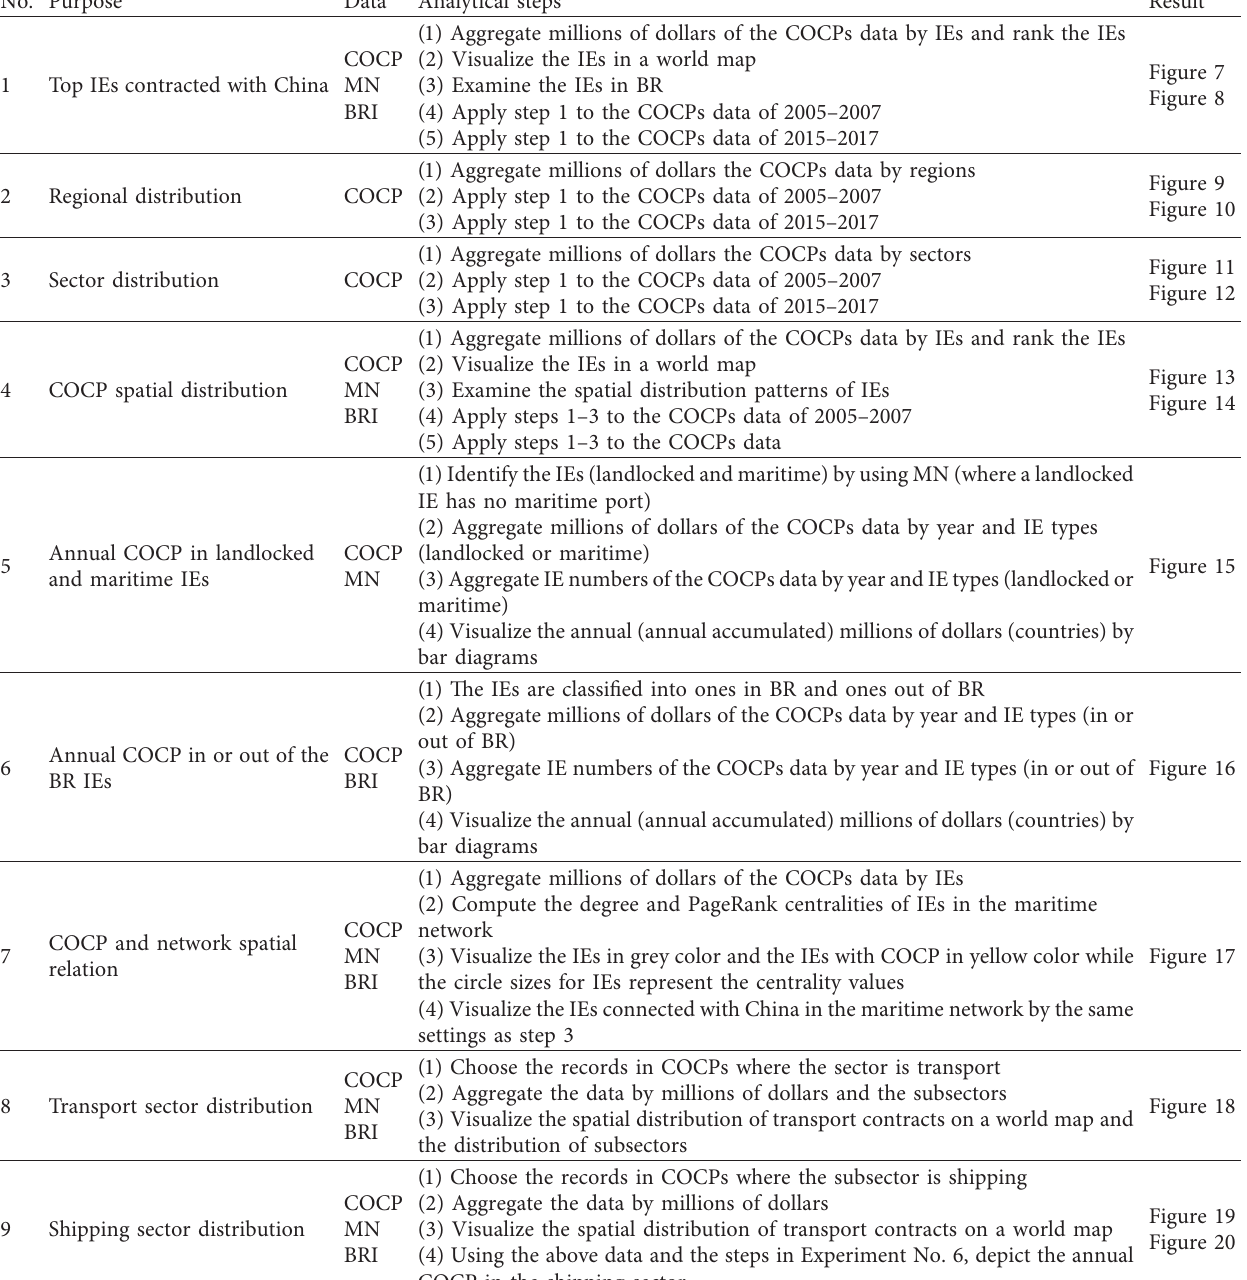
Table 4: Settings of the analytical